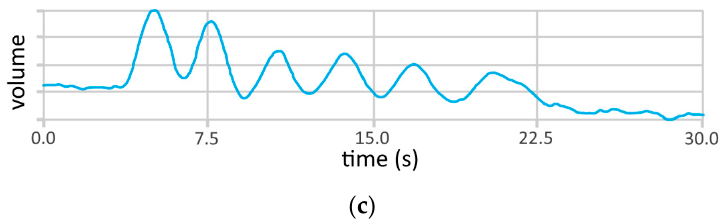
Figure 4. Examples of respiratory patterns in the RV signal from three separate studies. ( a ) Respiratory patterns generated by deliberately varying tidal volume cyclically. The ROI is fitted to the chest region using a flood fill technique. ( b ) Respiratory patterns manifest in a signal collected during a breathe-down study. The ROI is a rectangular subset of the chest. (Reprinted from [17].) ( c ) A simulated apnea signal. The ROI is the whole image.